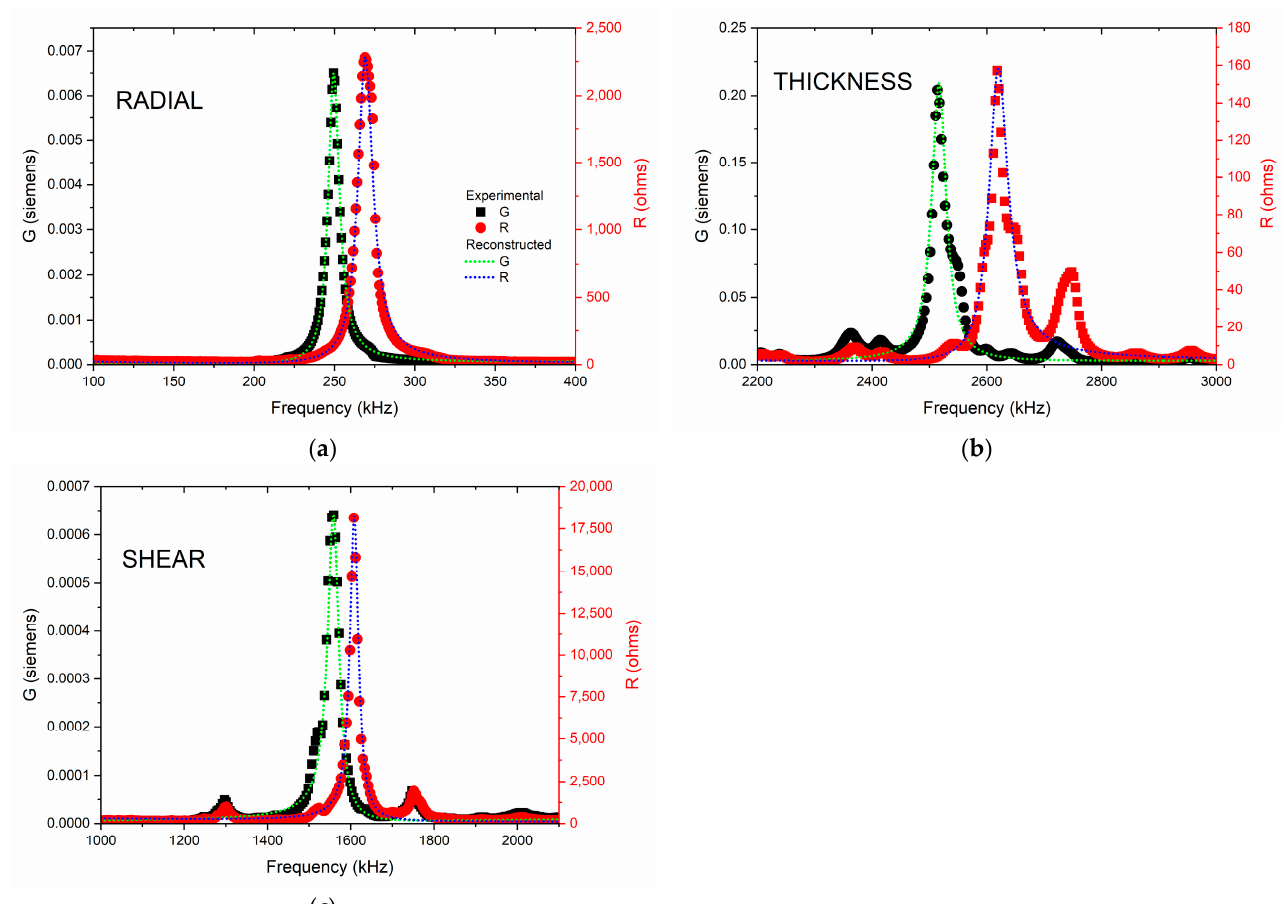
Figure 4. Impedance spectra as R and G plots of the: ( a ) planar resonance of a thin disk, thickness poled and excited, ( b ) thickness resonance mode of the same disk, and ( c ) shear resonance mode of thickness poled and longitudinally excited plates of BCZT8-5. The symbols are the experimental data, and the dotted lines are the reconstructed peaks after the calculation of the material